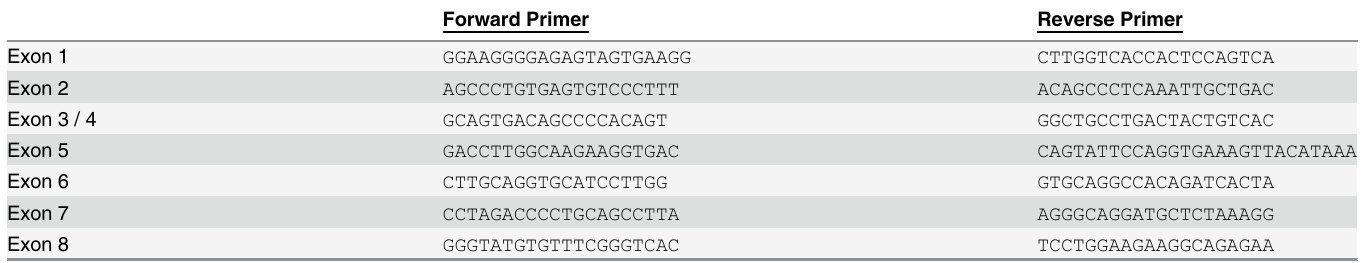
Table 1. SQSTM1 primer